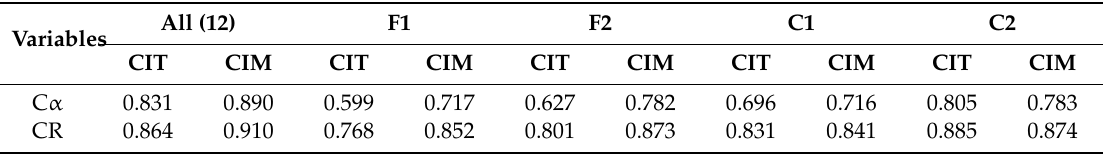
Table 16. Reliability tests of the questionnaire responses.